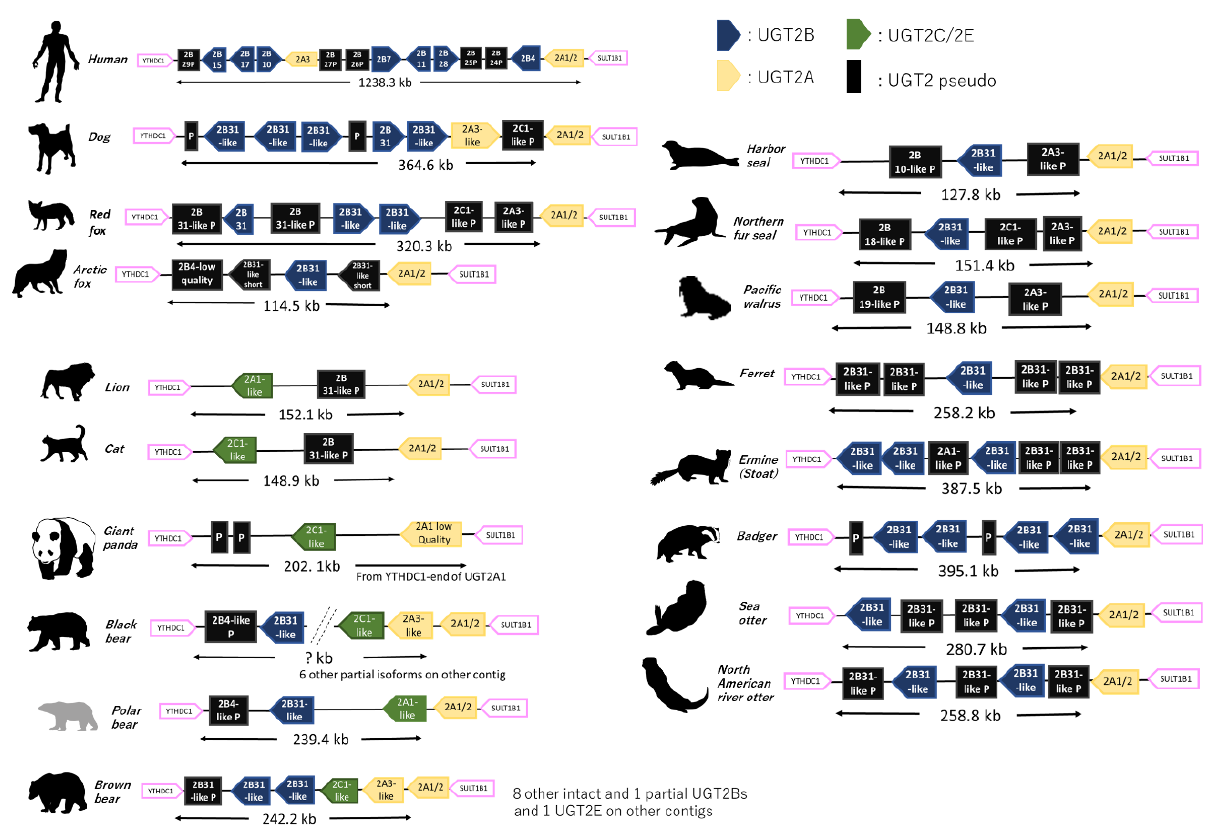
Figure 3. Synteny analysis of UGT2s in Carnivora. Synteny of UGT2 coding loci among Carnivora is shown. Representative species for each family were selected. UGT2A1/2 are known to share common exons (2–5) among isoforms and are shown as yellow blocks with the same color in other UGT2As. UGT2Bs are navy, UGT2E/2Cs are green, and pseudogenes are black. Lengths of coding loci from UGT2As to YTHDC1 are also shown as indicators for genetic loss in these loci.